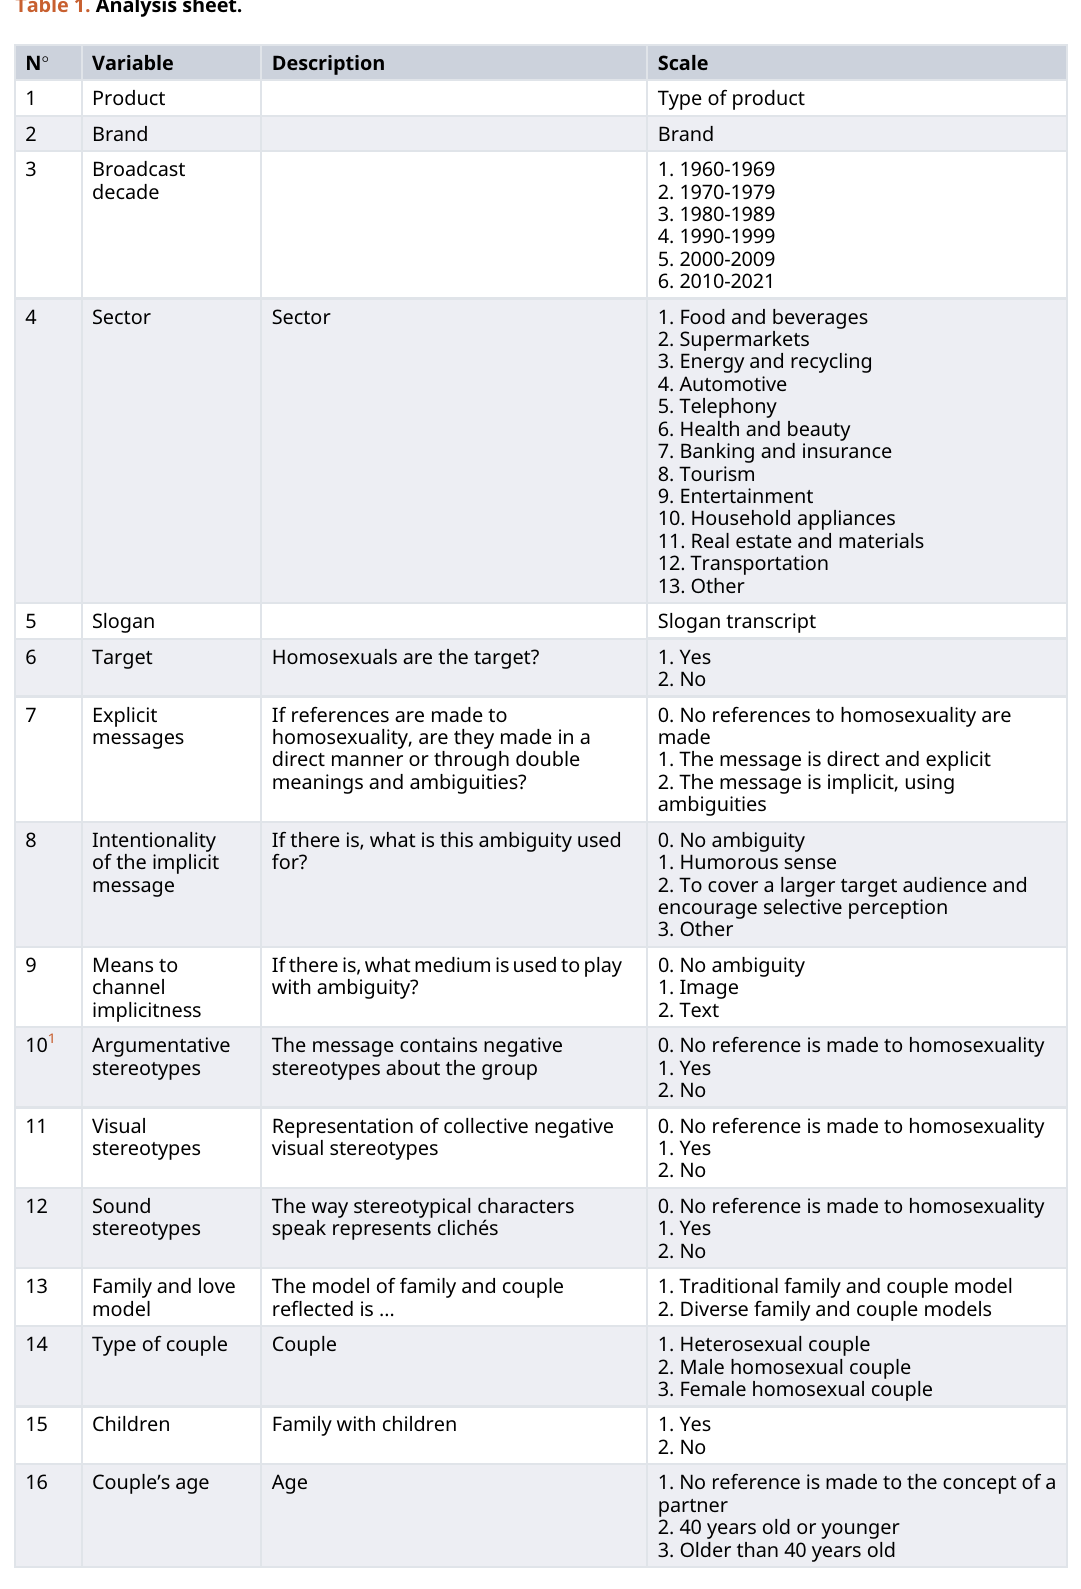
Table 1. Analysis